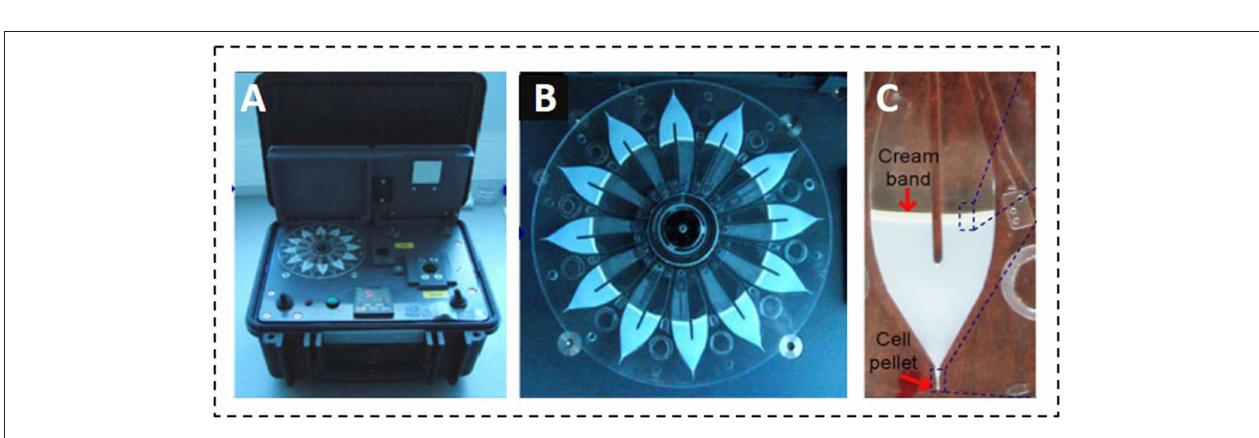
Integrated LoC systems for pathogen detection, combining sample treatment (using milk as target sample), nucleic acid amplification and detection are described in the